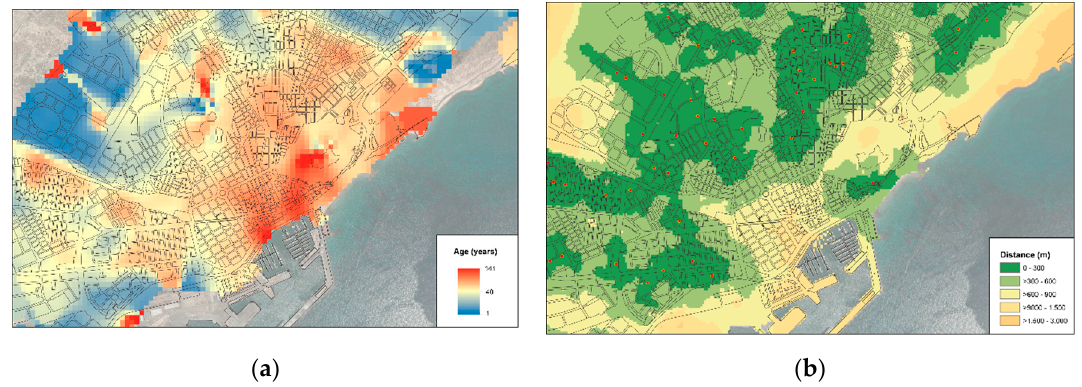
Figure 5. Maps of the city of Alicante: ( a ) age of the buildings and ( b ) distance from primary and secondary schools.